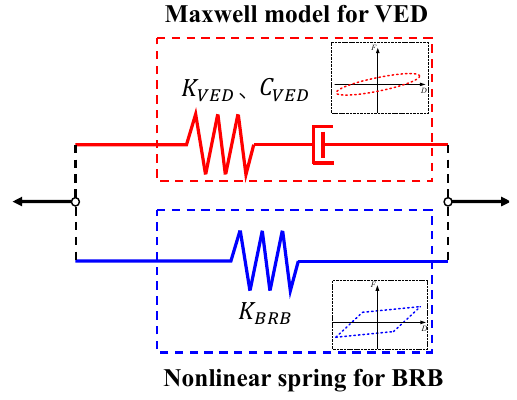
Figure 8. Dynamic model of VBRB.